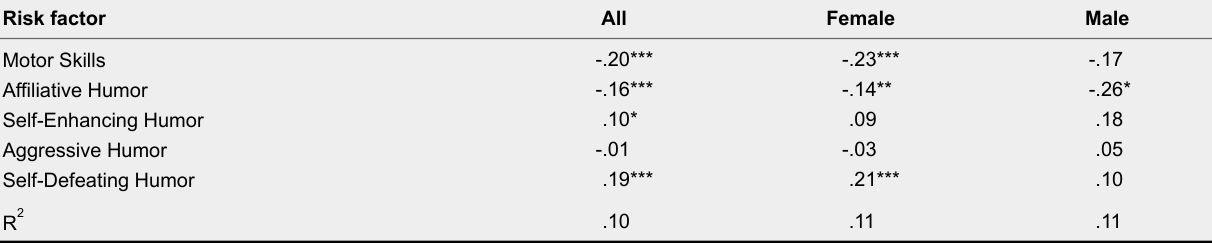
Multivariate Regression Predicting Being